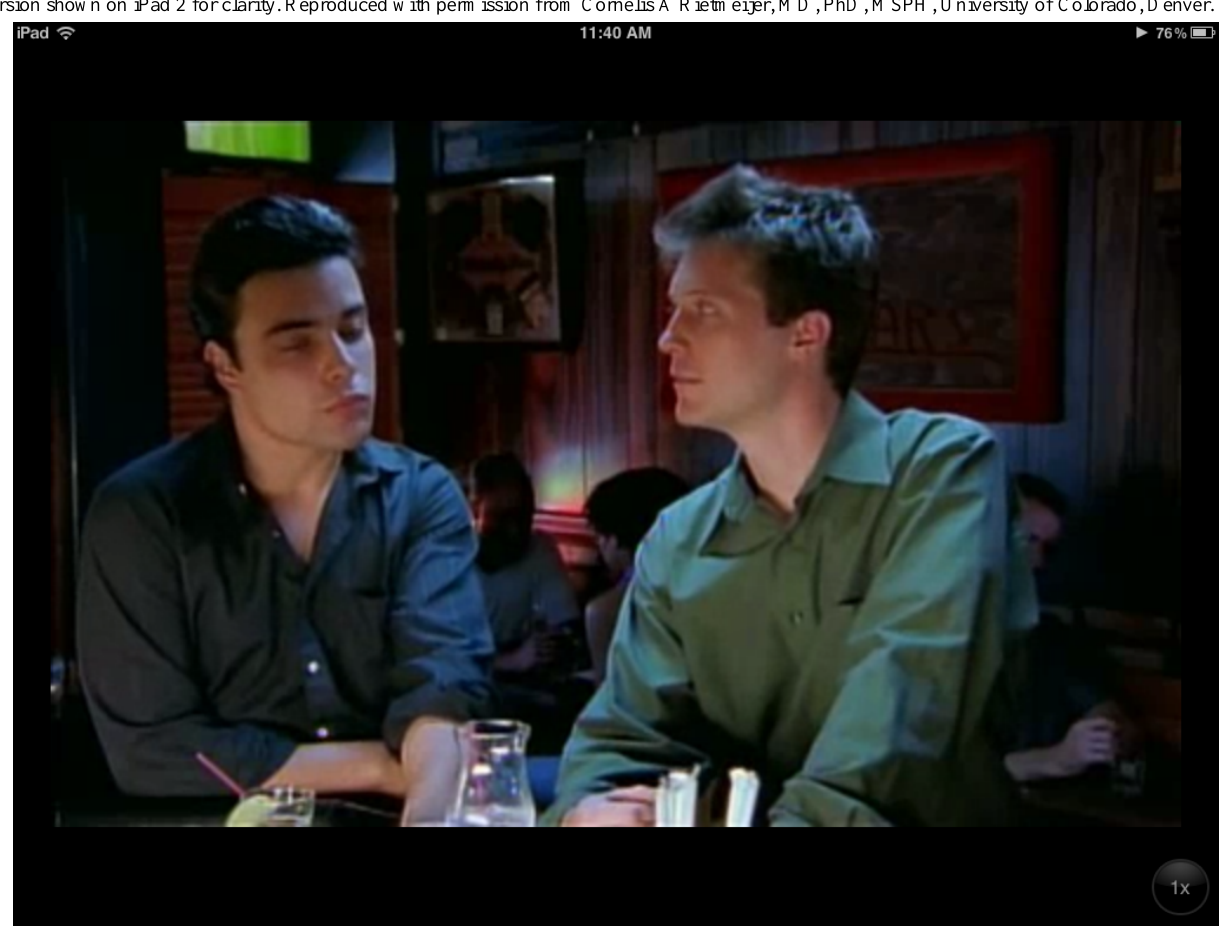
Figure 7. Screenshot of STDiQ app featuring a bar scene from Rueben’s one-night stand in the Safe in the City STD reduction intervention.